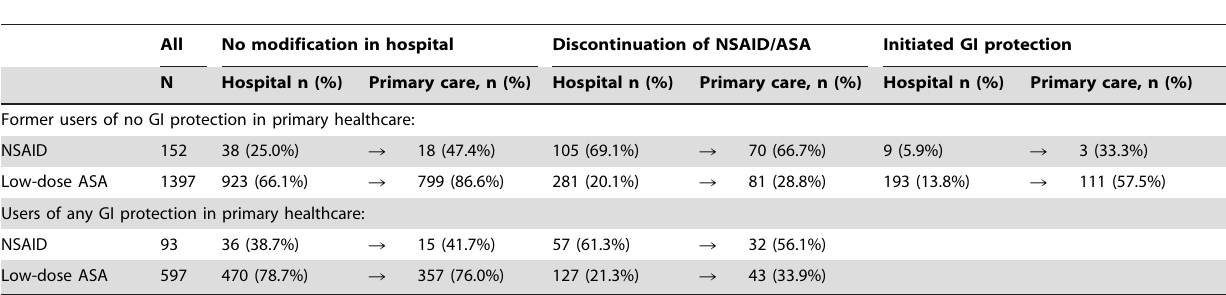
Table 2. Numbers and prevalence rates of concurrent use of GI protection for users of NSAID and low-dose ASA across